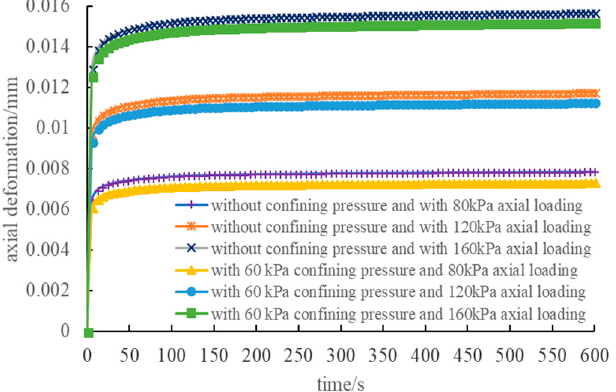
Figure 10. Axial deformation under different loading conditions.